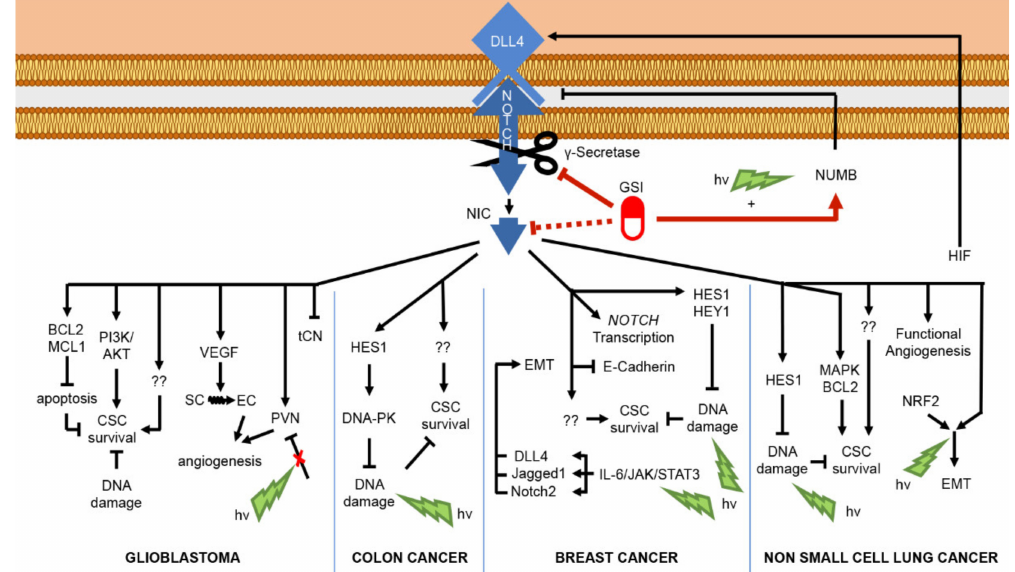
Figure 3. Schematic diagram of potential mechanisms mediating GSI effects on Notch-related cancer radioresistance. In glioblastoma, NIC sustains: CSC survival via the anti-apoptotic protein MCL1 (induced myeloid leukemia cell differentiation protein) and BCL2 (B-cell lymphoma 2) as well as via the pro-survival pathway PI3K/AKT; angiogenesis via VEGF (vascular endothelial growth factor) signaling that transforms stromal cells (SC) to endothelial cells (EC), and selecting the perivascular niche (PVN) cells. On the other hand, Notch1 knockdown stimulates the formation of cell-communicating network (tCN) inside the tumor. In colon cancer, HES1 counteracts the accumulation of DNA damage by sustaining DNA-PK (DNA- dependent protein kinase) implicated in DNA repair following exposure to radiation (h ν ), therefore sustaining CSC survival. In breast cancer, the Notch target genes HES1 and HEY1 are implicated in contrasting DNA damage accumulation, while NIC also mediates the inhibition of oncosuppressor protein E-Cadherin and the increase in CSC survival via unspecified mechanisms following exposure to h ν . Additionally, radiation stimulates the IL-6/JAK/STAT3 axis that upregulates DLL4, Jagged1, and Notch2 expression that promote EMT. In NSCLC, NIC sustains CSC survival via HES1, MAPK (mitogen- activated protein kinase), and BCL2 upregulation and is implicated in the functional angiogenesis. In addition, HIF is associated with DLL4-related Notch stimulation, and radiation stimulates the NRF2/Notch axis that enhances EMT. Finally, in NSCLC, the combined GSI-radiation therapy results in Numb-dependent downregulation of Notch. “??” represents other unknown mechanisms which may be involved in Notch-dependent CSC